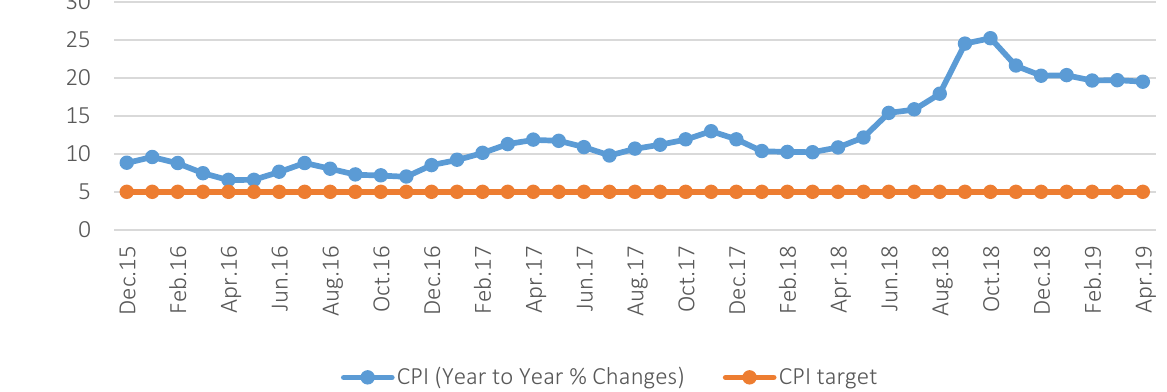
Figure 5. Factual and target annual inflation rate in